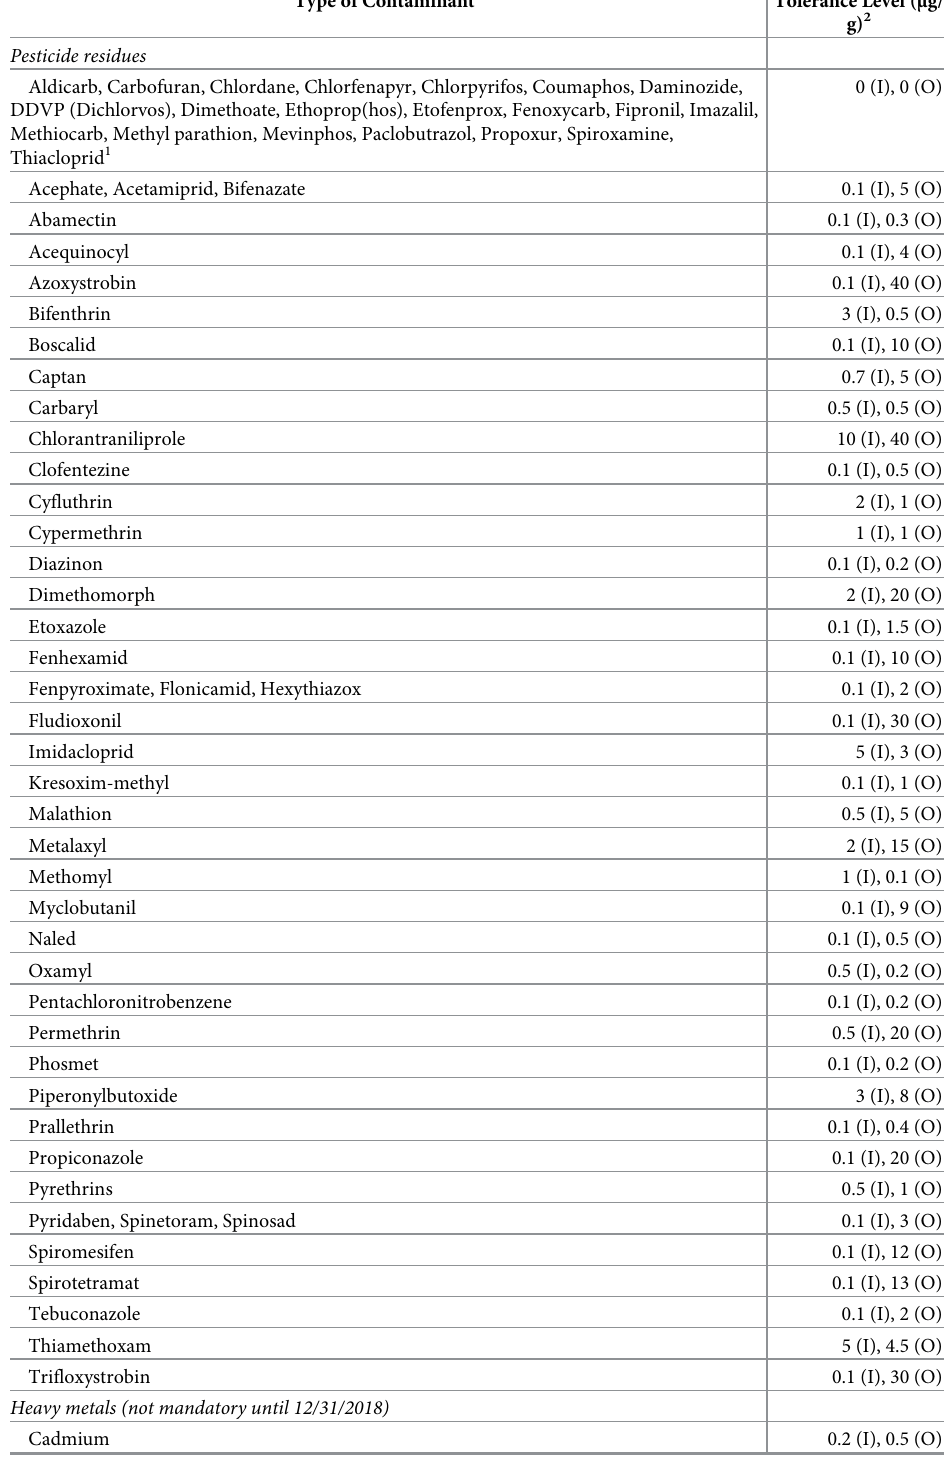
Table 2. Tolerance levels for pesticide residues, heavy metals, residual solvents, and processing chemicals in can- nabis and cannabis products in